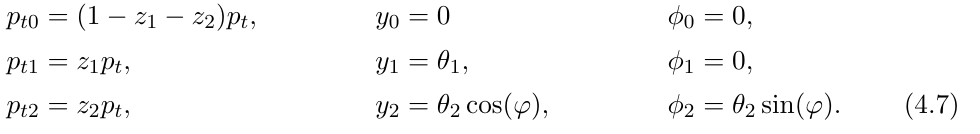
=(cid:28) (min) 21 21